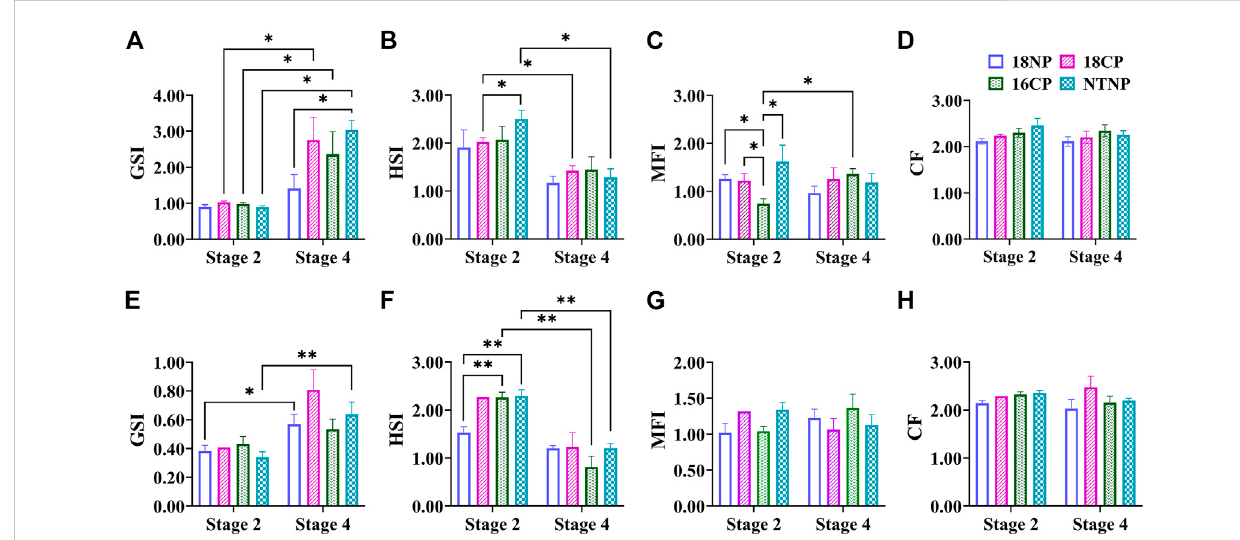
FIGURE 4 Variations of somatic indexes including GSI, MFI, HSI, and CF during thermo-photoperiod manipulation of largemouth bass. ( A – D) Female GSI (gonadosomatic index), MFI (mesenteric fat index), HSI (hepatosomatic index), and CF (condition factor). ( E – H) Male GSI, MFI, HSI, and CF. Stage 2 , supposed maturation of ovary, right after temperature increase, 25 September. Stage 4 , the supposed spawning peak, spawning was observed in all treatment groups, on 21 November. These stages were pointed out in Figure 3. Asterisk (*) indicates a signi fi cant difference between Stage 2 and Stage 4, or between treatment groups. 18NP , 18 ° C overwintering water temperature, natural photoperiod group. 18CP , 18 ° C overwintering water temperature, controlled photoperiod group. 16CP , 16 ° C overwintering water temperature, controlled photoperiod group. NTNP , natural water temperature and natural photoperiod group.